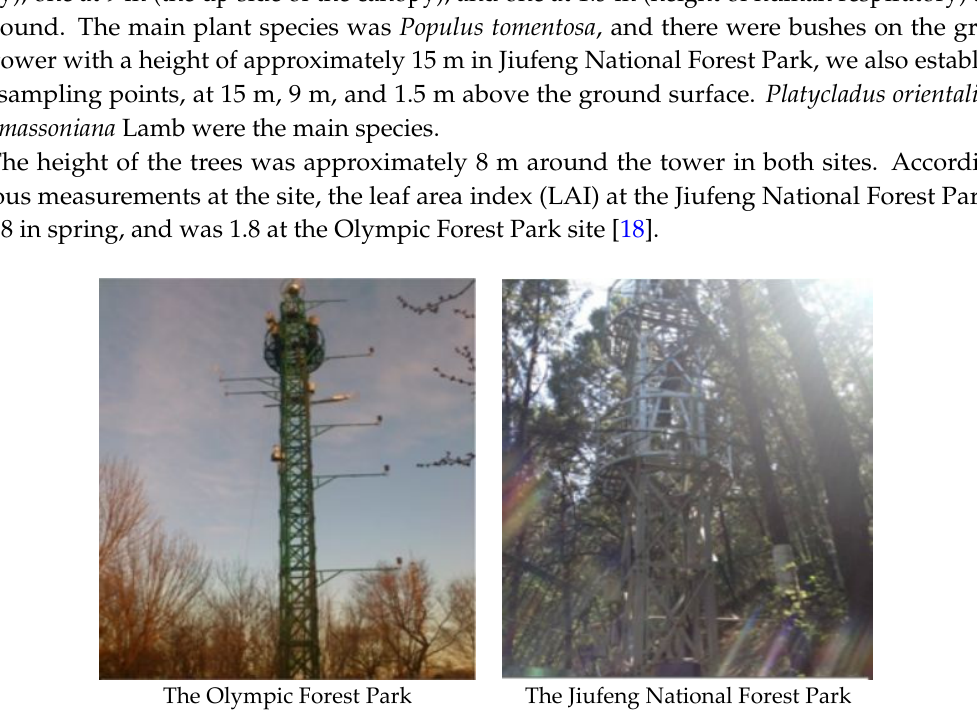
Figure 1. The experimental towers of Olympic Forest Park and Jiufeng National Forest Park.